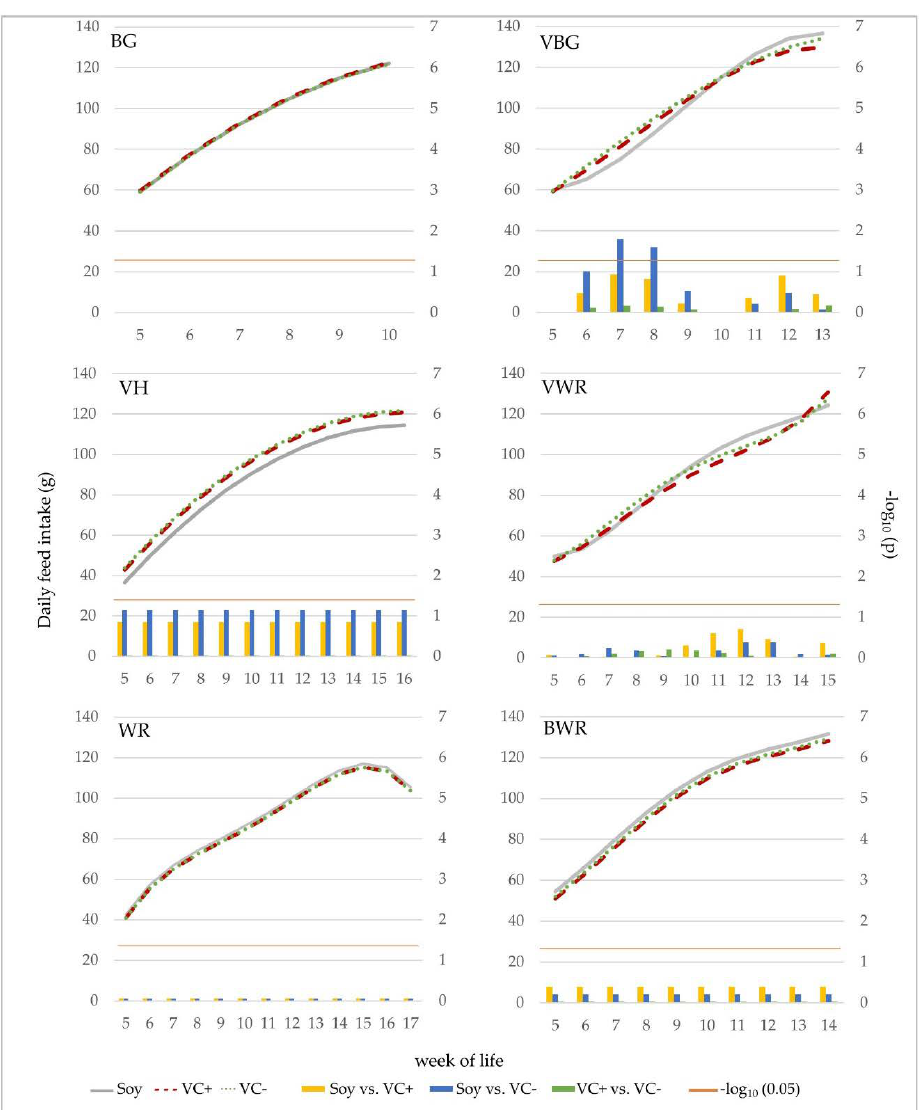
Figure 4. Effect of feeding treatment on daily feed intake (DFI) within genotypes. Curves show development of DFI for the respective feeding groups. The bar charts exhibit the differences between LS-means of the different combinations of feeding groups on a weekly base. The orange line represents the significance threshold of p = 0.05. Bars that cross this line imply significant differences between feeding groups in the respective week.